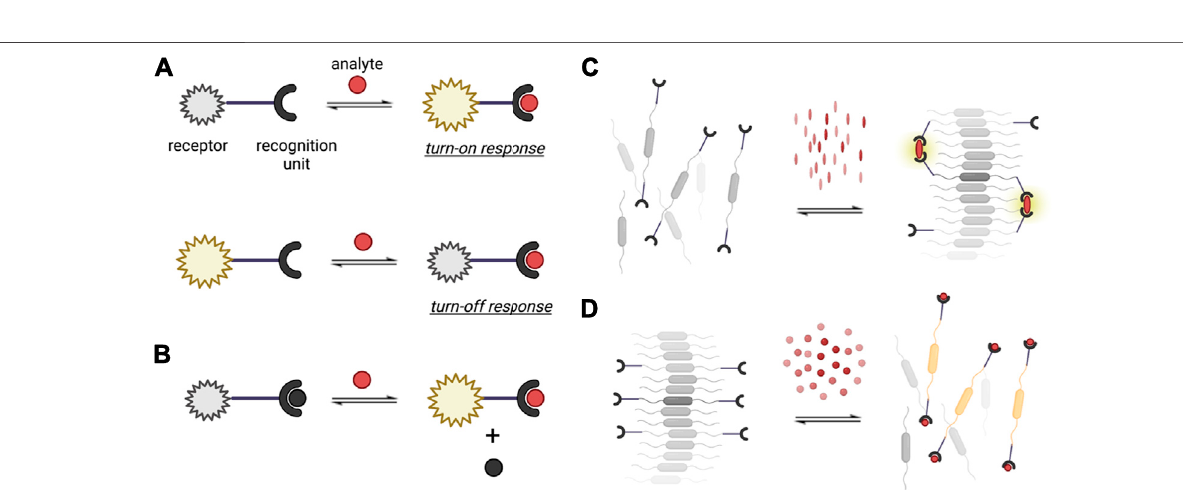
Frontiers in Chemistry |